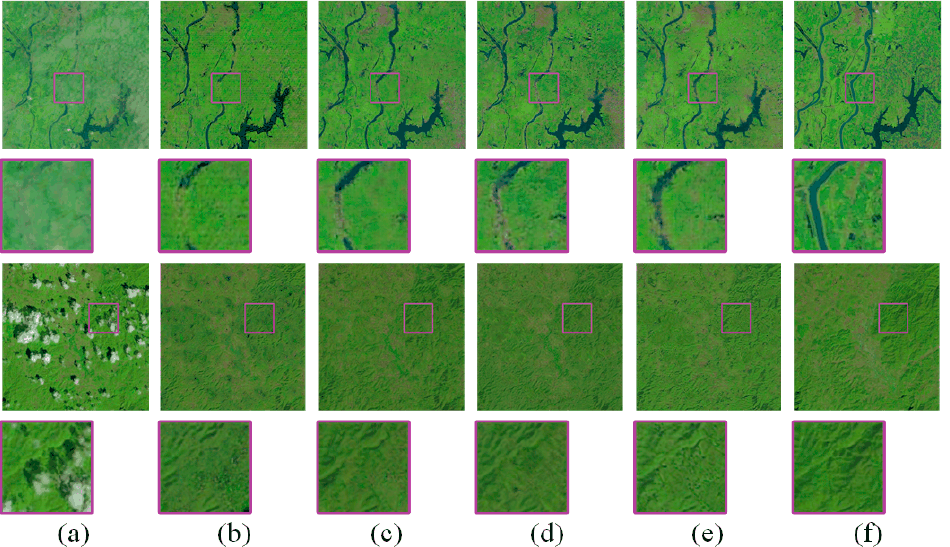
Figure 11. Results of an ablation study of different components of the network architecture on the RICE2 test set. ( a ) Cloudy images; ( b ) baseline; ( c ) baseline + L cs ; ( d ) baseline + L cloudy + L non − cloudy ; ( e ) DC-GAN-CL; ( f ) cloud-free images.